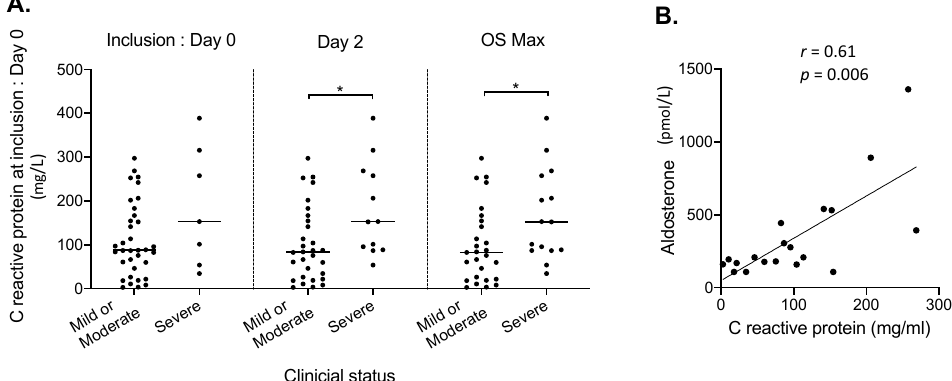
Figure 3. (A ) C reactive protein level at inclusion according to clinical status of patients with Covid-19 infection at Day 0, Day 2, and maximum ordinal scale (OS) during the overall period of hospitalization (OS max). The median values are shown (crossbar), in two groups of clinical status severity: mild or moderate (OS ≤ 4, n = 29)) and severe (OS ≥ 5, n = 15). * p < 0.05 (Mann–Whitney test). ( B ) Correlation between aldosterone and C reactive protein at inclusion.